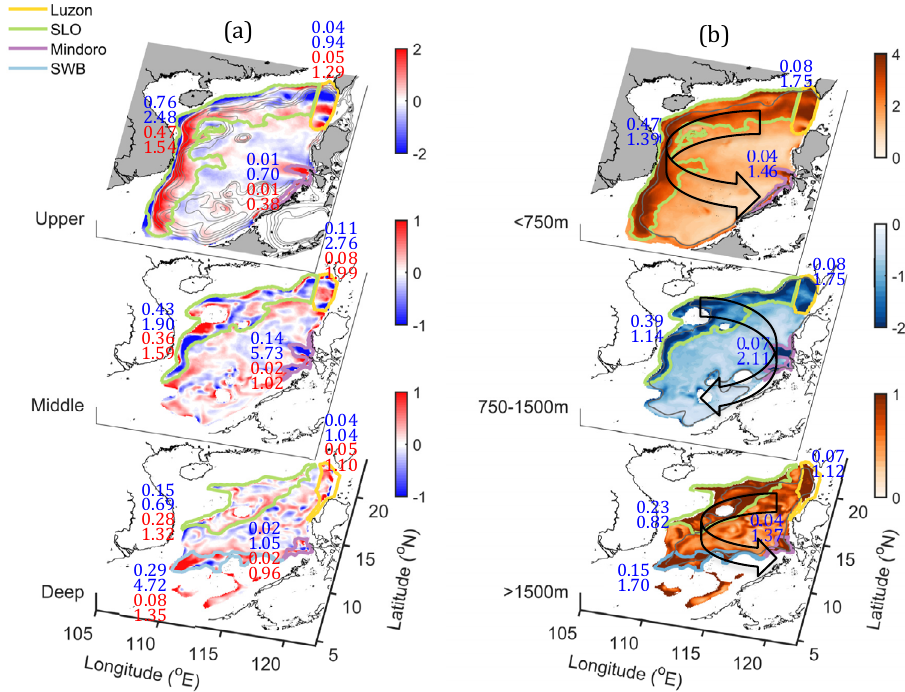
Fig. 2 Net vorticity and hotspot vorticity in the layered circulation. a Horizontal distribution of the depth-averaged vorticity (10 − 5 s − 1 ) contributed to the formation of cyclonic-anticyclonic-cyclonic (CAC) circulation in the upper, middle, and deep layer. b Same as a but showing favorable vorticity ( ζ f ) to the CAC circulation. The hotspots include regions off Luzon Strait (LS), along the slope (SLO), near Mindoro Strait (MS) and in the southwest basin (SWB), which are bounded by the respective yellow, green, purple and blue thick contour lines. The regions of the hotspots are de fi ned with vorticity thresholds of the 20-year mean values in the respective layer. The upper and lower values in each hotspot are IR (M) and AR (M) (blue), IR (E) and AR (E) (red) in a and IR vort and AR vort in b , which measure the contributions of mean kinetic energy ( M ), eddy kinetic energy ( E ) and vorticity ( VORT ) to hotspot, respectively. IR and AR are de fi ned by Eqs. (2) and (3) in Methods section. The isobaths of the 200 m, 500 m, 1000 m, 1500 m, and 2000 m in the upper layer in a indicate the location of the slope. The 1500 m and 3000 m isobaths are shown in the middle and deep layers in b ,